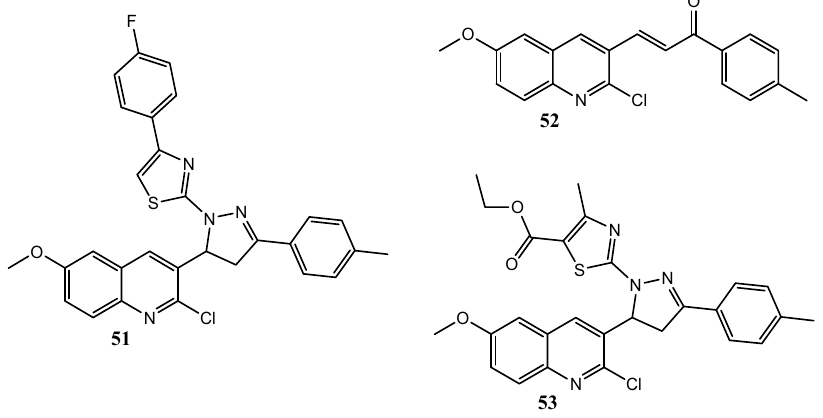
Figure 25. Pyrazoline / pirazolinylthiazole quinoline hybrids [123].